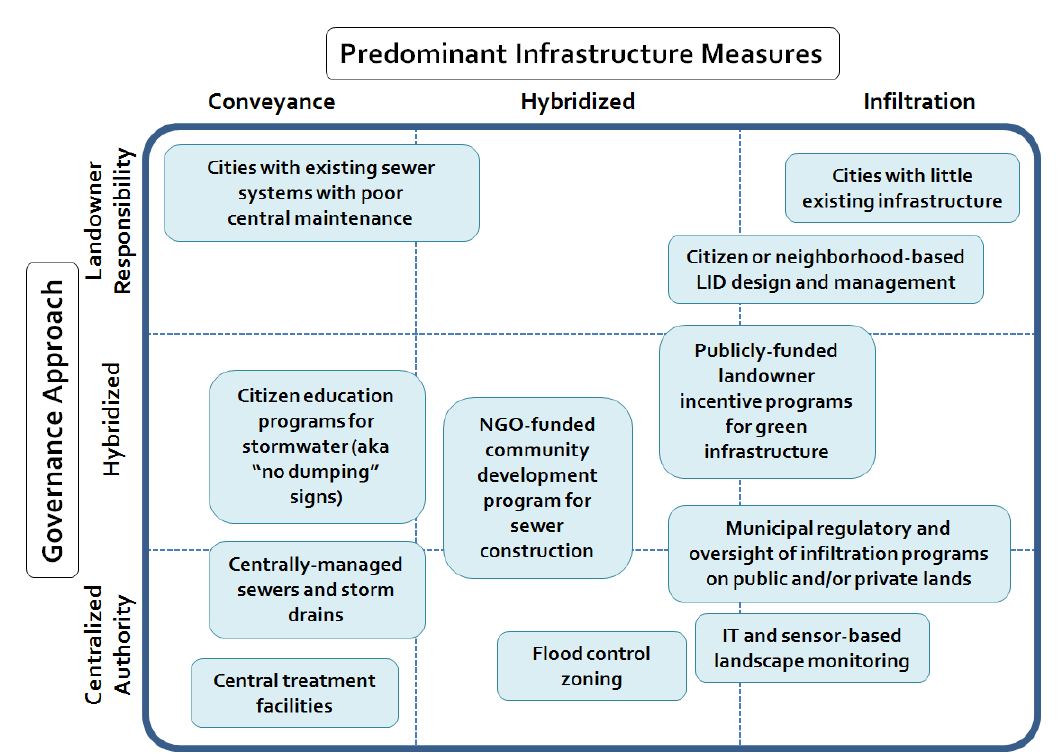
Figure 1. Conceptual model for hybridization in stormwater governance and